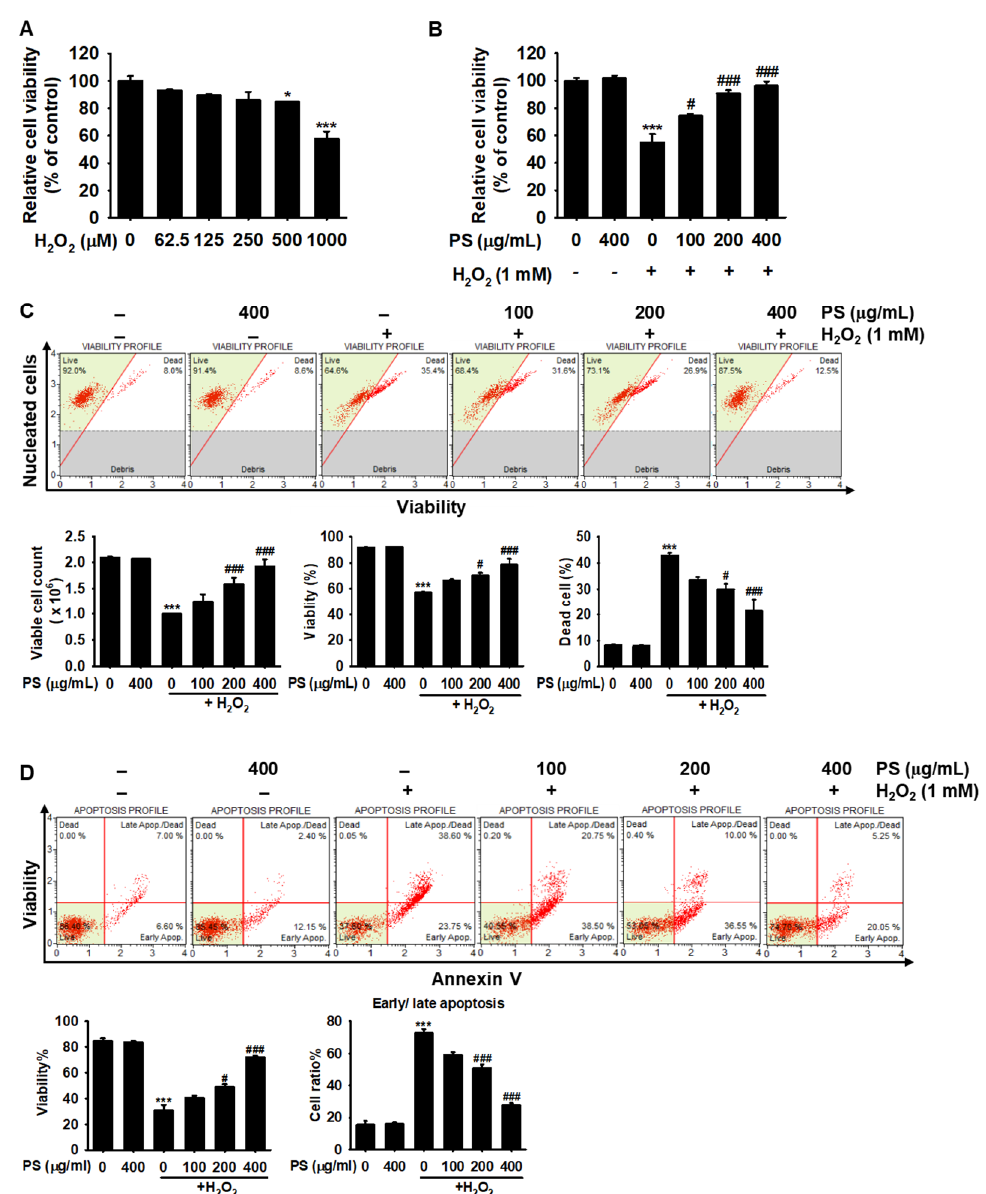
Figure 2. PS protects HaCaT keratinocytes against H 2 O 2 -induced apoptosis. ( A ) HaCaT keratinocytes were seeded at a density of 1 × 10 4 cells/mL and treated with H 2 O 2 at the indicated concentrations (0–1000 μM) for 4 h. Relative cell viability was measured by the MTT assay. ( B – D ) In a parallel experiment, HaCaT keratinocytes were treated with the indicated concentrations of PS (0–400 μg/mL) for 20 h prior to exposure to 1000 μM H 2 O 2 for 4 h. ( B ) Relative cell viability was measured by the MTT assay. ( C ) Viable cell count, percentage of viability, and dead cell populations were analyzed by flow cytometry using Muse ® Count & Viability Kit. ( D ) Annexin-based viability and early/late apoptosis were measured by flow cytometry using Muse ® Annexin V & Dead Cell Kit. Graphs represent viability and proportion of cells in early/late apoptosis. Significant differences among the groups were determined using one-way ANOVA followed by Bonferroni correction. All data are averaged from three independent experiments and are presented as mean ± the standard error of the median [*** p < 0.001 and * p < 0.05 vs. the untreated group (UT) and ### p < 0.001 and # p < 0.05 vs. the H 2 O 2 -treated group].